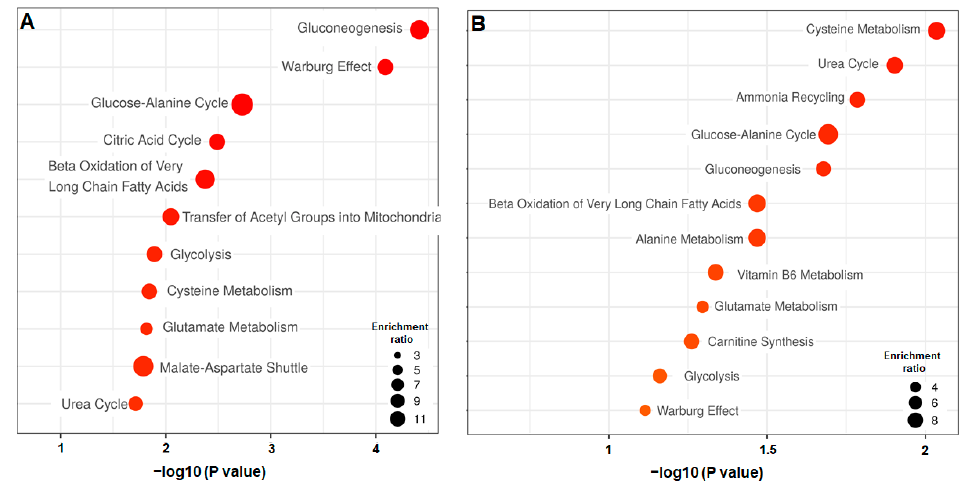
Figure 5. Pathway impact enrichment extracted from the Petri and biochip cultures comparisons. ( A ) biochip culture after 3 days (BC_d3) vs. Petri cultures after 3 days (PT_d3) comparison; ( B ) biochip culture after 5 days (BC_d5) vs. Petri cultures after 5 days (PT_d5) comparison.